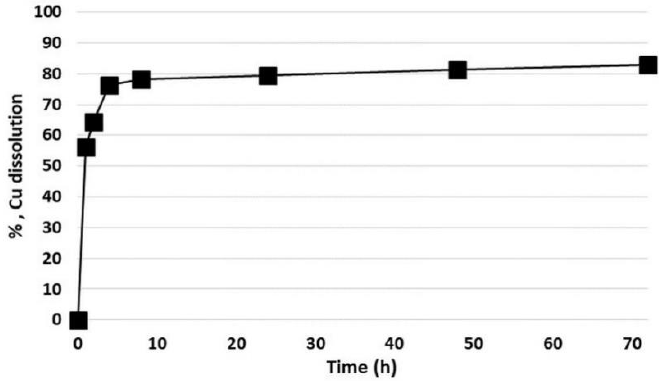
Figure 4. Copper extraction under oxidizing conditions using O 3 . Solution potential controlled at 1000 mV and 25 °C and using 50 g/L H 2 SO 4 .